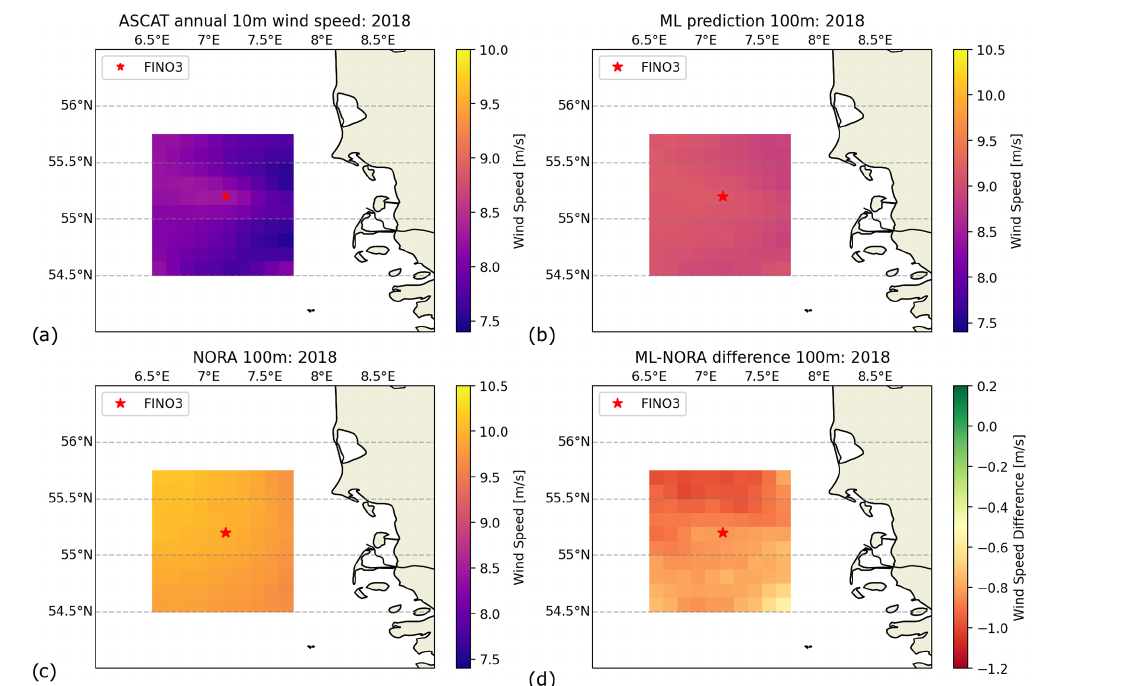
Figure 4. (a) Mean ASCAT wind speed at 10m for 2018 around FINO3. (b) RFM-predicted mean wind speed at 101m for 2018. (c) Mean NORA3 wind speeds at 100m collocated and regridded to the ASCAT WVCs. (d) Wind speed difference between (b) and (c)